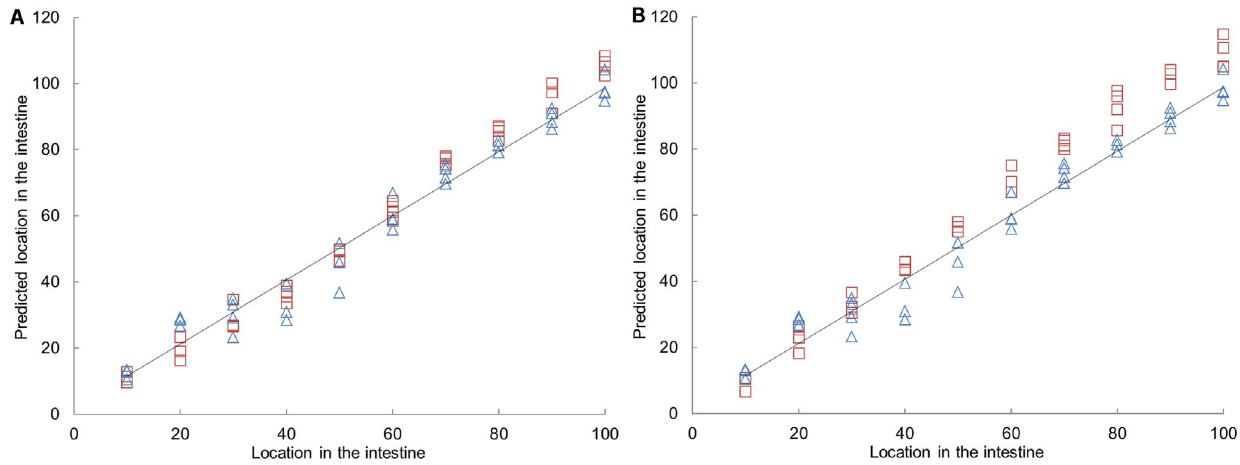
Figure 3. PLS prediction of locations along the intestine based on the gene expression in a sample. The PLS prediction model used 3 factors and has an R 2 =0.9681. The samples of mice fed a chow diet ( D ) were the basis of the model and the data of mice fed a low-fat (A, indicated with % ) and high-fat diet (B, indicated with % ) was fitted in the model.